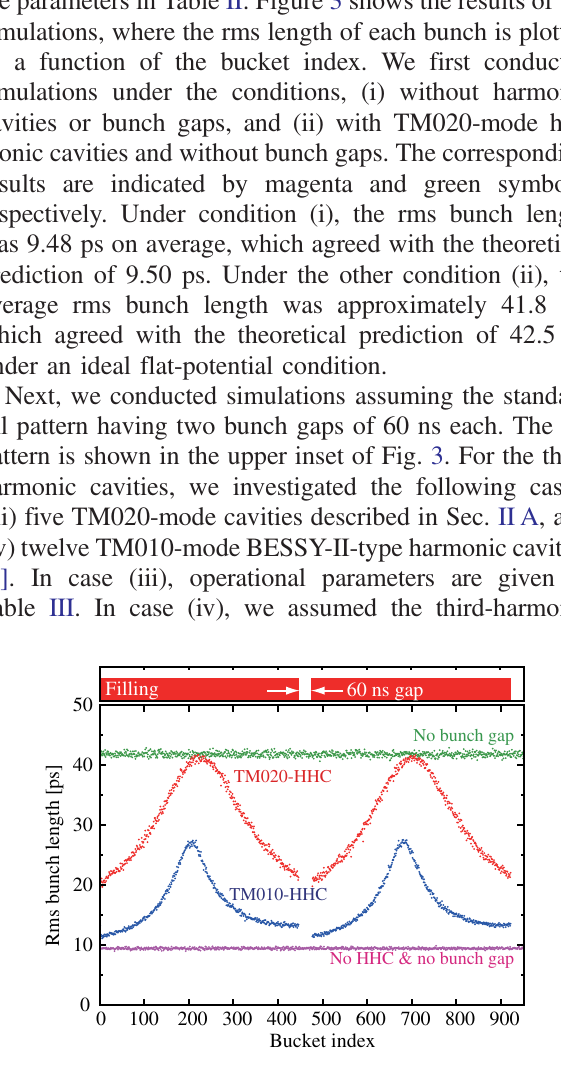
FIG. 3. Results of the tracking simulations showing rms bunch lengths along the bunch trains. Abscissa shows the index of the rf buckets. The upper inset indicates the standard fill pattern of the ring. Symbols in different colors indicate the bunch lengths under the conditions: (magenta) without bunch gap or harmonic cavities, (green) without bunch gap and with the third harmonic cavities, (red) with bunch gaps of 60 ns and using the TM020- mode harmonic cavities, and (blue) with bunch gaps of 60 ns and using BESSY-II-type TM010-mode harmonic